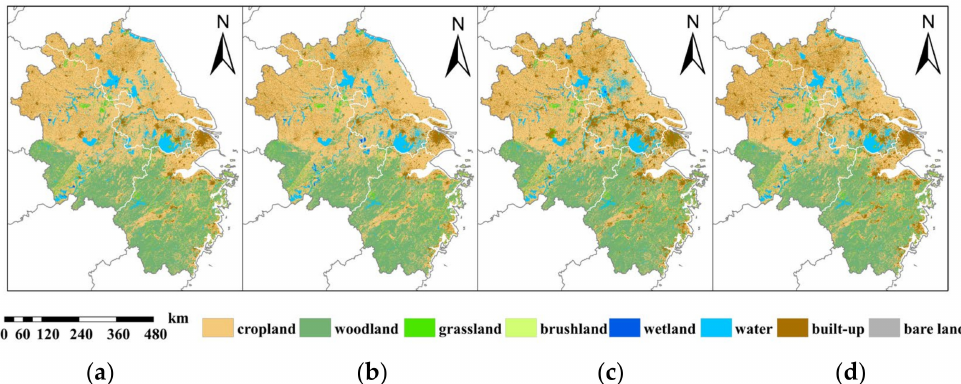
Figure 8. Comparison between simulated land use patterns and Globeland30 data: ( a ) GlobeLand30 of 2010, ( b ) simulated land use of 2010, ( c ) GlobeLand30 of 2020, ( d ) simulated land use of